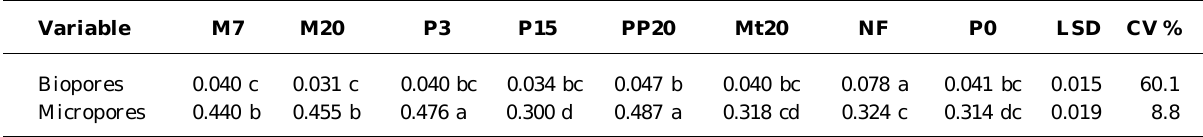
Areas studied: M7: maize, 7 years of organic fertilizer applications; M20: maize, 20 years of application; P3: annual pasture, 3 years of application; P15: annual pasture, 15 years of application; PP20: perennial pasture, 20 years of application; Mt20: yerba mate, 20 years of application; NF: native forest; P0: native pasture. Capital letters, in the rows, compare layers and small letters, in the columns, compare use systems, by the t test (p<0.05). LSDS: least significant difference; CV: coefficient of